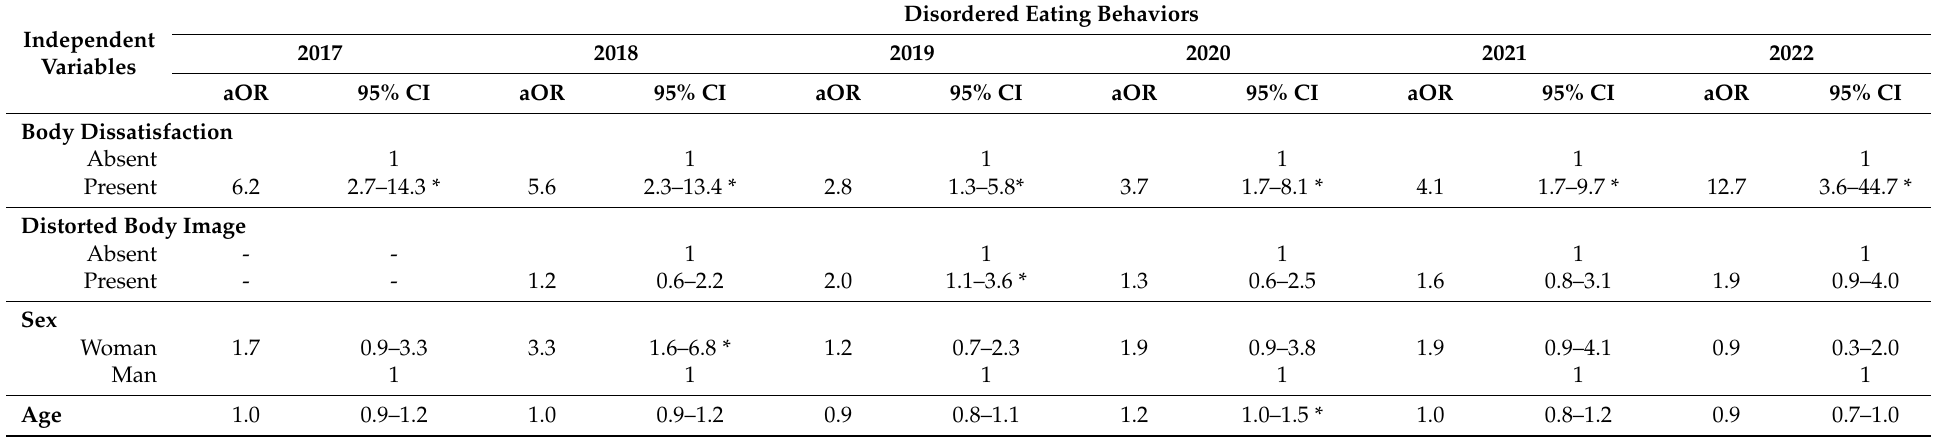
aOR = Adjusted Odds Ratio. * Statistically significant p